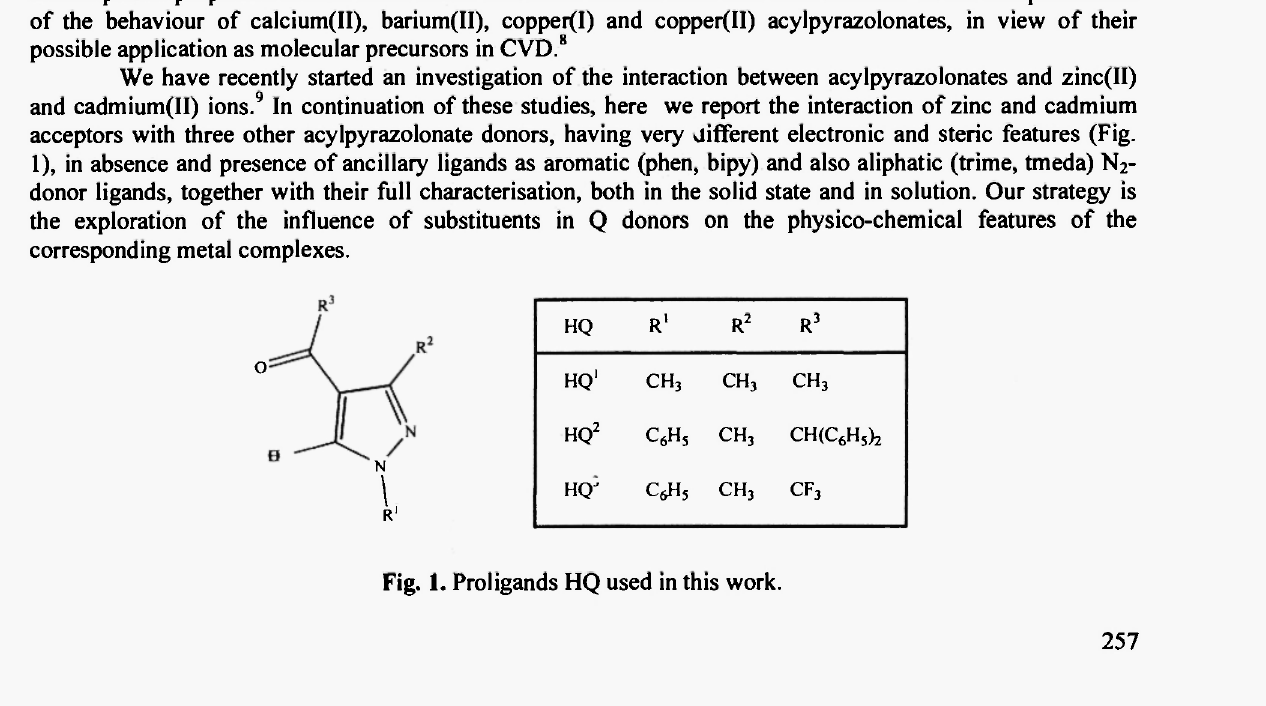
Fig. 1. Proligands HQ used in this